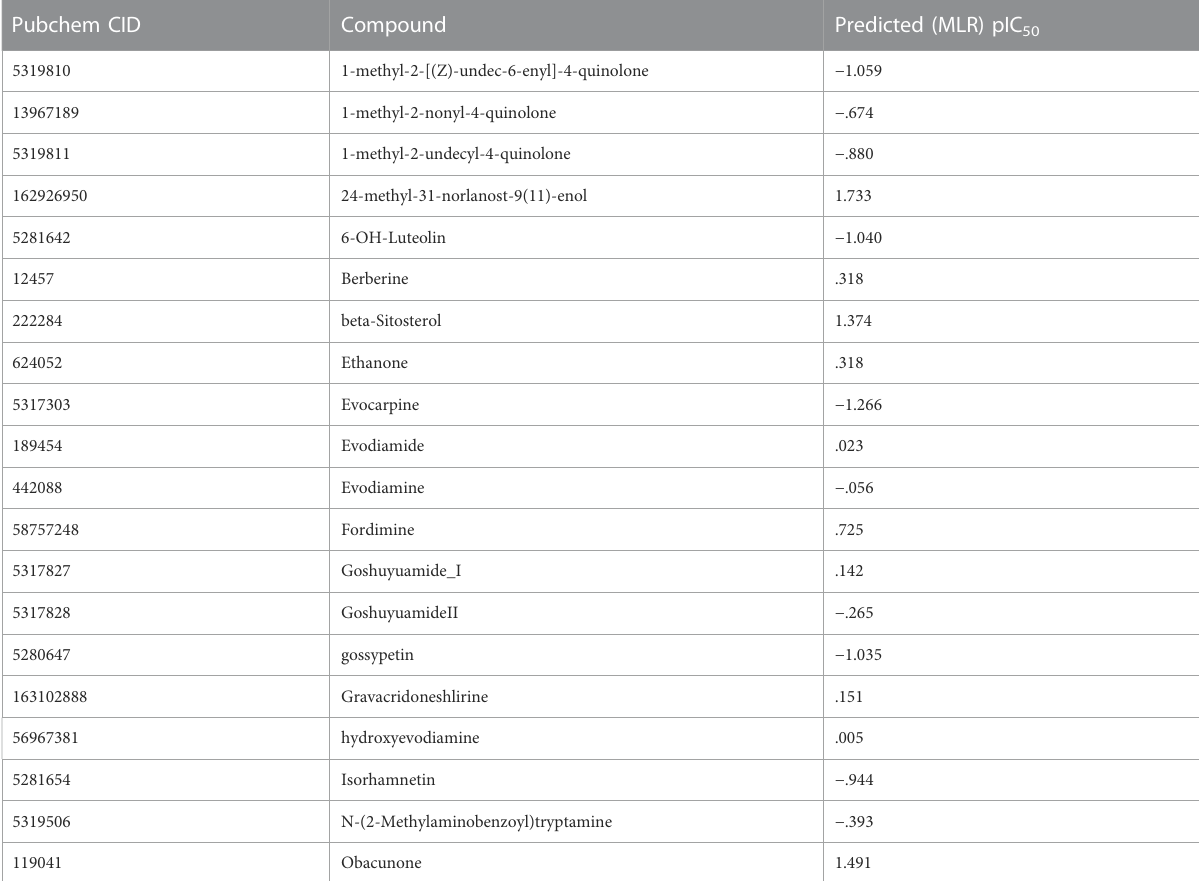
TABLE 2 The activity pIC50 ( μ M) of PD Based on the 2D-QSAR model. Pubchem